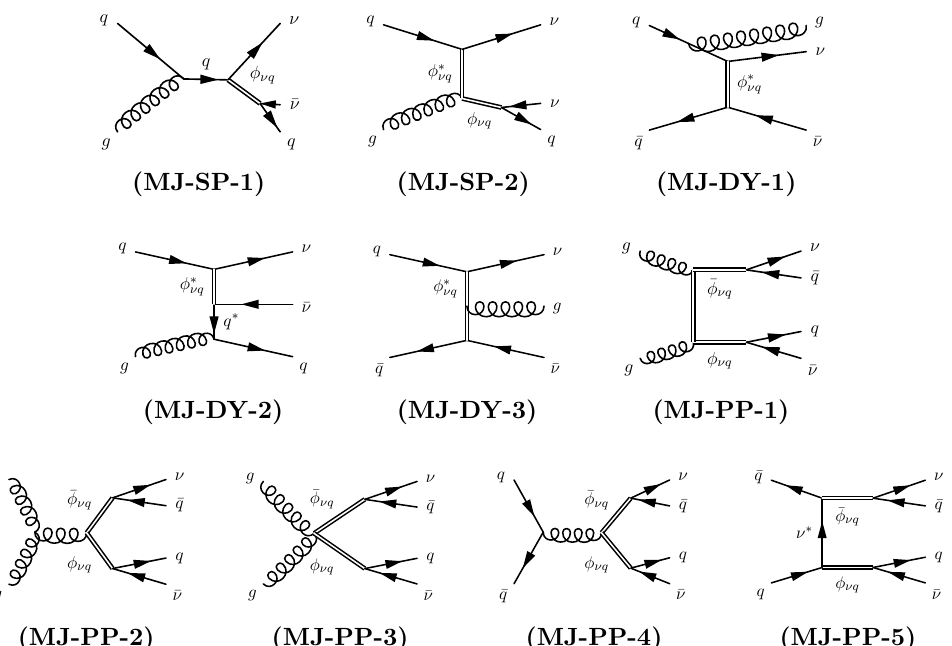
Figure 11. Leading order diagrams contributing to the monojet searches for (cid:30) (cid:23)q . Searches for (cid:30) (cid:23)q are identical to searches with (cid:13)avored-dark-matter for vanishing dark matter mass. Diagrams can be classi(cid:12)ed as MJ-SP (here the monojet is the decay product of a singly produced leptoquark), MJ-DY (here the monojet stems from NLO radiation emanating from a process which is DY-like at leading order). In addition, we include 2 j + =E T from leptoquark pair production MJ-PP because monojet searches usually allow a second hard jet and hence are also sensitive to the 2 j + =E T signal. Other 2 j + =E T diagrams with one or zero leptoquarks on shell are less signi(cid:12)cant in the parameter space that we are interested in. Hence we do not show them